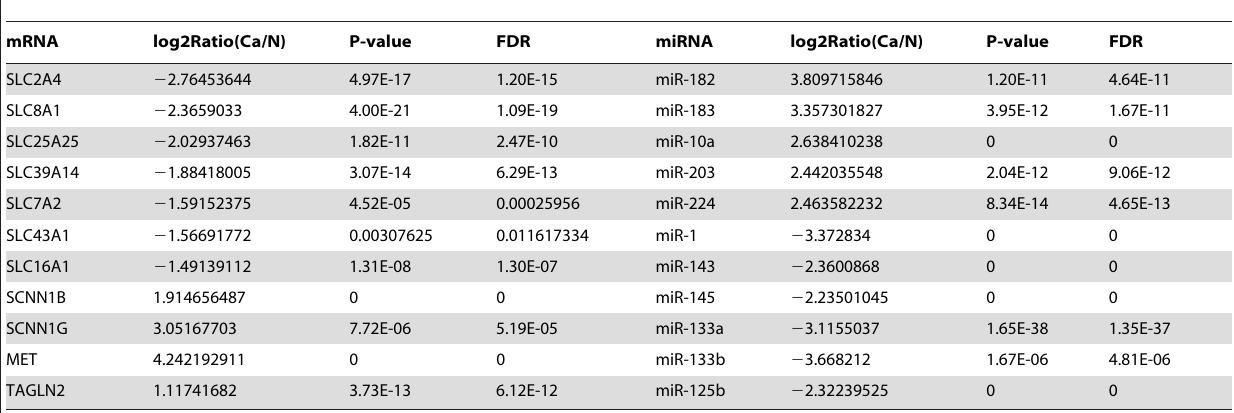
Table 1. A collection of deregulated mRNAs and miRNAs detected by deep sequencing in bladder cancer.